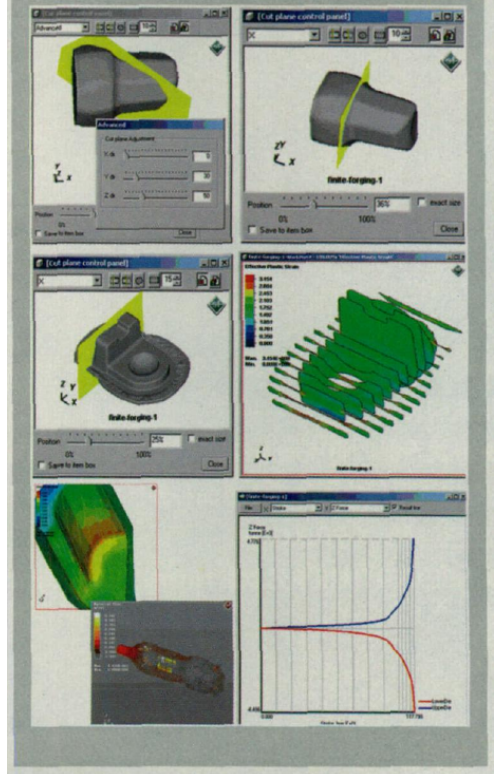
Fig. 2 Display of Simufact simulation results.